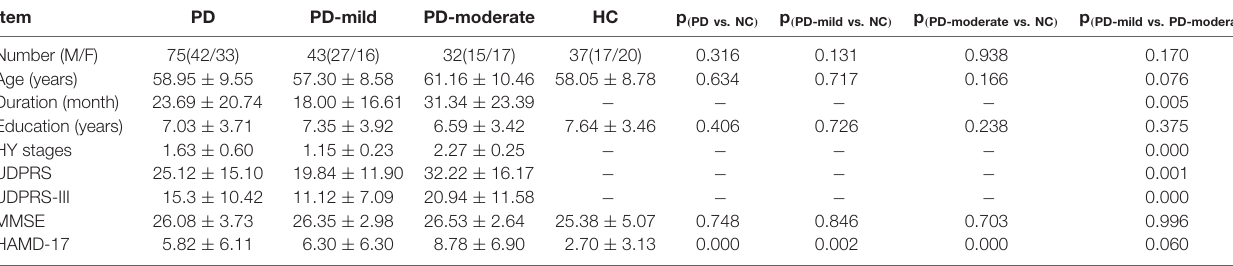
TABLE 1 | Demographic information and clinical characteristics of the three groups.